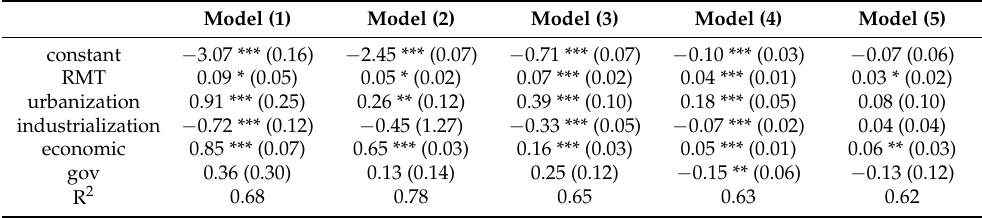
Table 1. Results of Panel